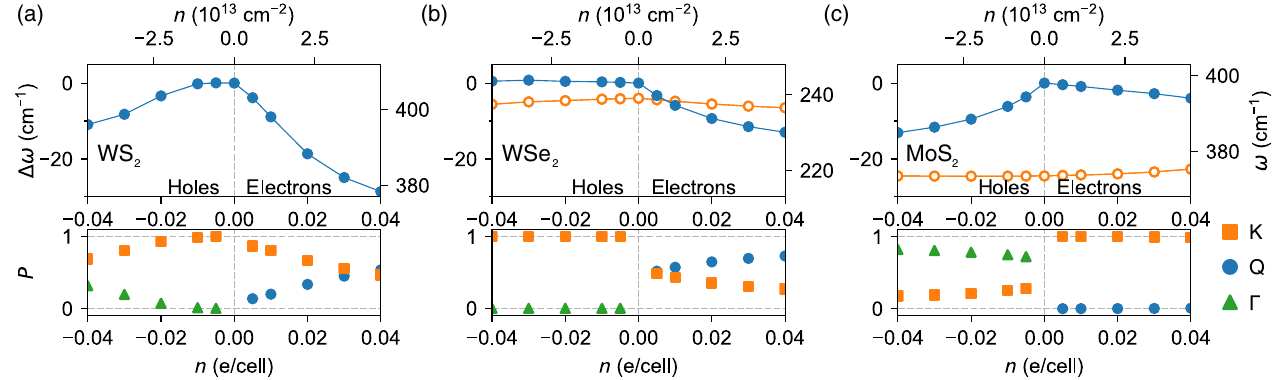
FIG. 6. Top panels: Results of ab initio calculations showing the dependence of the A 1 mode frequency (blue circles) on carrier g density n in monolayer WS 2 (a), WSe 2 (b), and MoS 2 (c), for either electron ( n > 0 ) or hole ( n < 0 ) accumulation, as indicated in each panel. The range of carrier density considered in the calculations roughly corresponds to that explored in the experiments [see Fig. 2(a)]. For WSe 2 and MoS 2 , we also plot the results for the E 2 mode (orange empty circles), which is found not to shift, in agreement with g experiments (for WS 2 , the E 2 mode is degenerate with the A 1 mode, which experimentally prevents its separate determination upon g g varying carrier density). Lower panels: Relative fractional occupation P of the different valleys upon hole and electron accumulation, as extracted from ab initio calculations done to obtain the density dependence of the phonon frequencies shown in the corresponding top panels. Different symbols refer to the K (orange squares), Q (blue circles), and Γ (green triangles) valleys. Note how in all cases — i.e., for all the different monolayers and upon both electron and hole accumulation — there is a perfect correlation between the shift of the A 1 g mode and the multiple occupation of valleys (i.e., the K and Γ valleys in the valence band upon hole accumulation, and the K and Q valleys in the conduction band upon electron